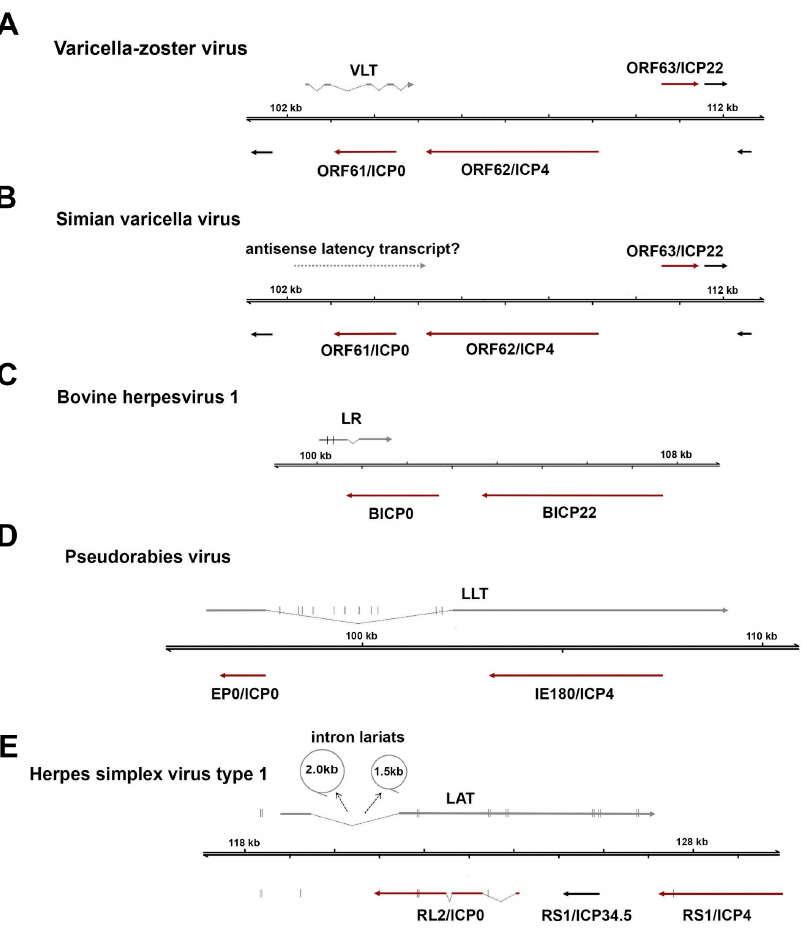
Figure 3. Comparison of latency-associated transcripts among alphaherpesviruses . All alphaherpesvirus 3 latency-associated transcripts ( LATs ) are located antisense to the infected cell polypeptide 0 (ICP0) locus, encoding a conserved major immediate-early transactivator (ICP0 or homologs). ( A ) The VZV latency-associated transcript ( VLT ) is a 496-nucleotide, multi-exon mRNA that is partially antisense to the ORF61 coding region via exons 3 and 4. ( B ) Transcripts mapping antisense to simian varicella virus ORF61 are expressed during latency (dotted arrow), but their identity has not yet been defined. ( C ) Bovine herpesvirus 1 encodes a 2.2 kb latency-related ( LR ) RNA and encodes two miRNAs in exon 1 ( D ) The pseudorabies virus large latency transcript ( LLT ) is the largest characterized alphaherpesvirus latency transcript and encodes eleven distinct miRNAs within the spliced intron. ( E ) The 8.2 kb herpes simplex virus type 1 (HSV-1) LAT undergoes splicing which yields two highly stable intron lariats, approximately 1.5 and 2.0 kb in size (shown as circles). Note that latency transcripts are shown as grey arrows, immediate early viral transactivators as dark red arrows, and encoded miRNAs as short vertical lines. Scaling across all schematics is